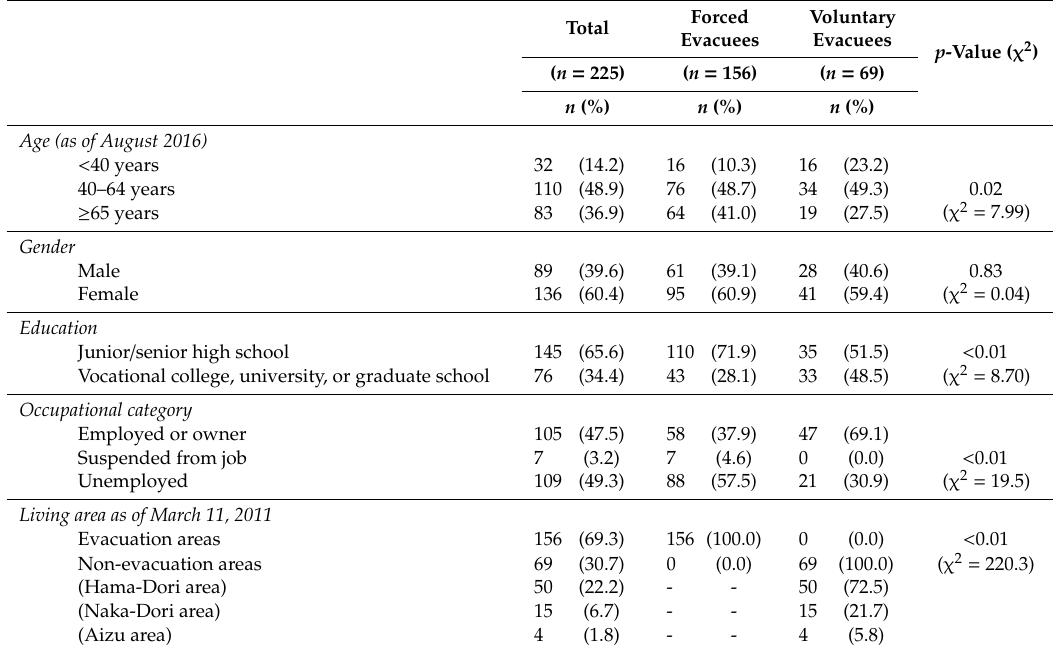
Table 1. Basic characteristics of the participants (forced / voluntary